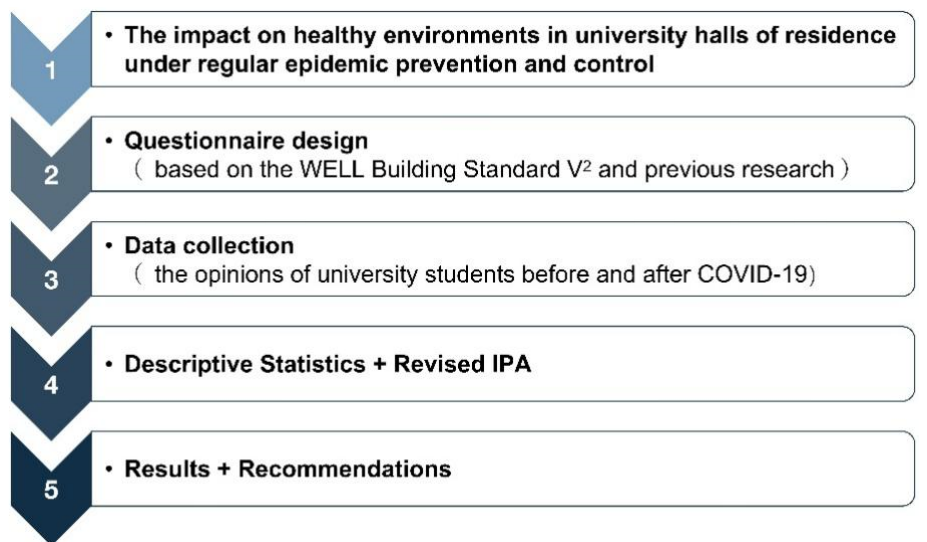
Figure 1. The logical